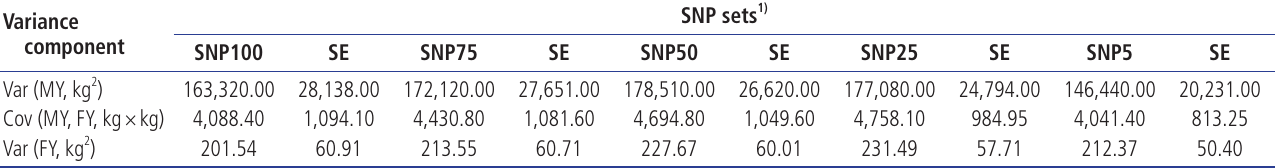
Table 2. Additive genetic variances and covariances for MY and FY estimated with five SNP sets using genomic-polygenic models Variance component